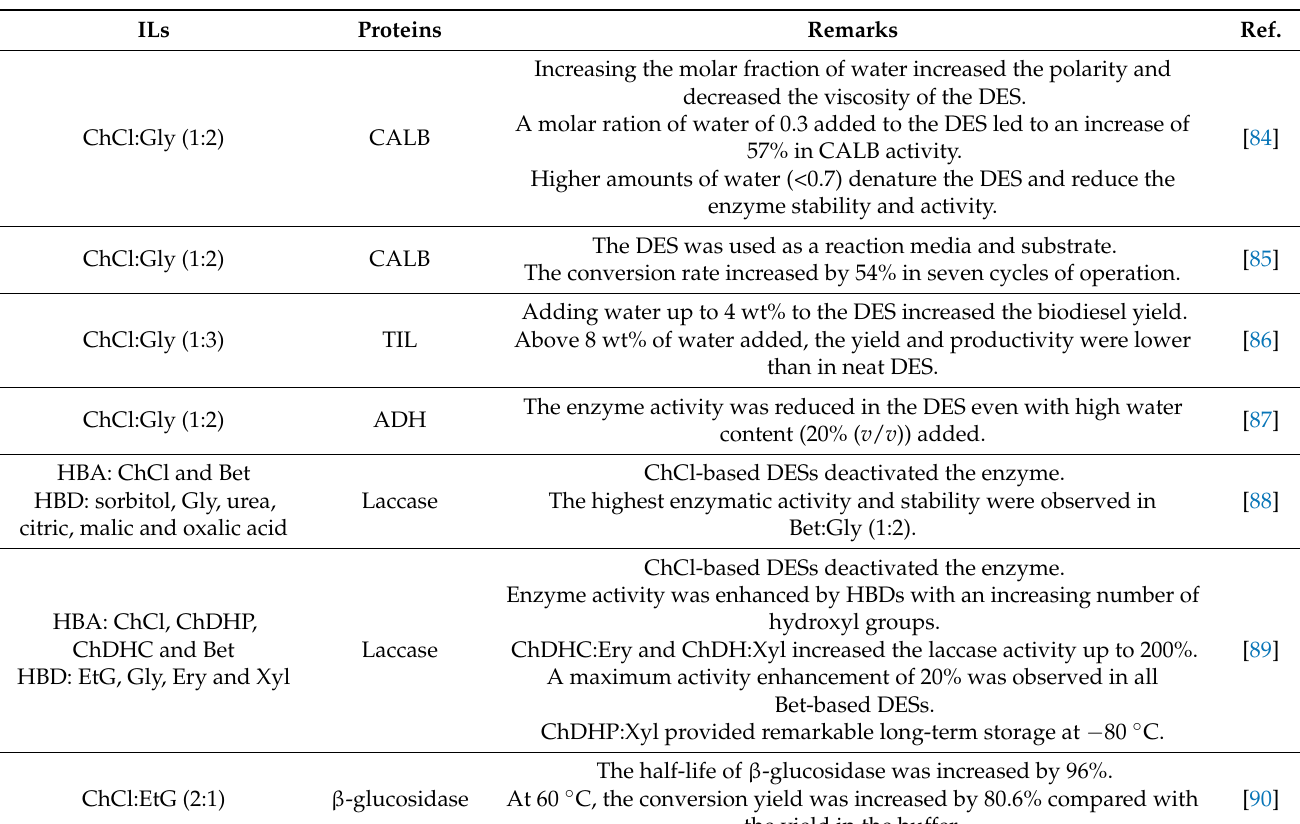
Table 3. Summary of the studies reporting the stabilization of enzymes in